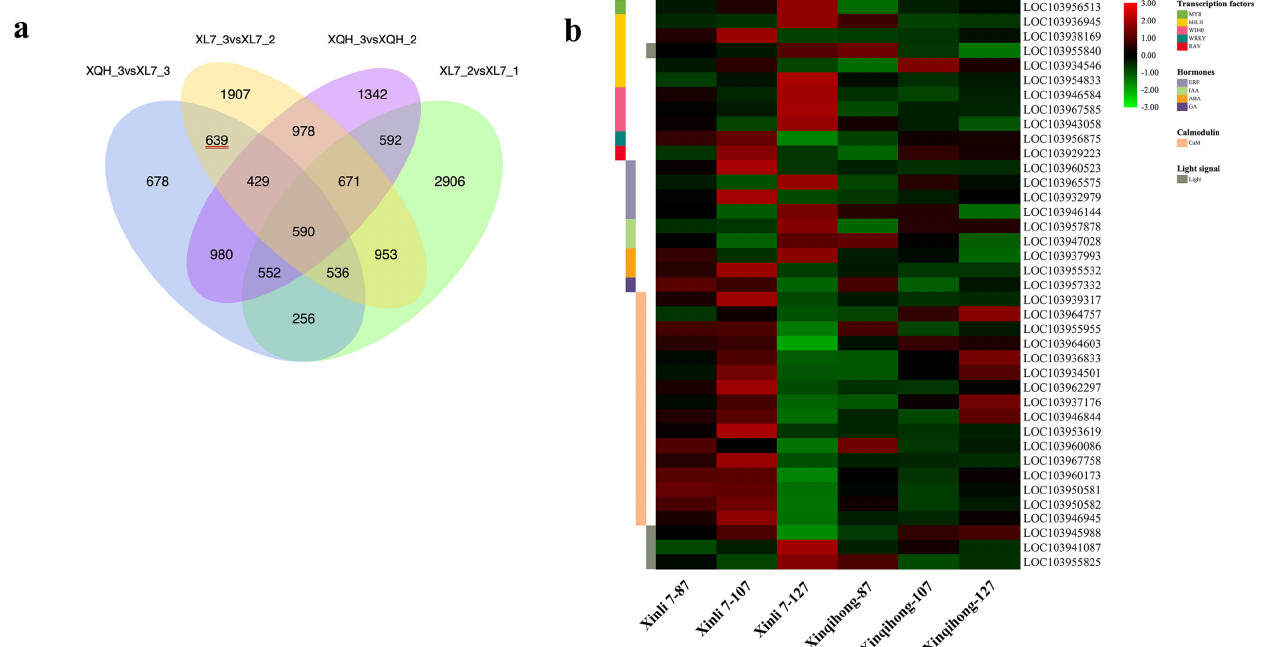
Figure 3. Analysis of DEGs. ( a ) Venn diagram of DEGs at 3 stages of fruit development (87, 107, and 127 DAFB) identified by RNA-seq in 2 red pear cultivars (‘Xinli 7 ′ and ‘Xinqihong’). ( b ) Fragments per kilobase of transcript per million mapped reads (FPKM) levels of candidate genes encoding TFs, hormones, calmodulin, and light signaling pathway components.